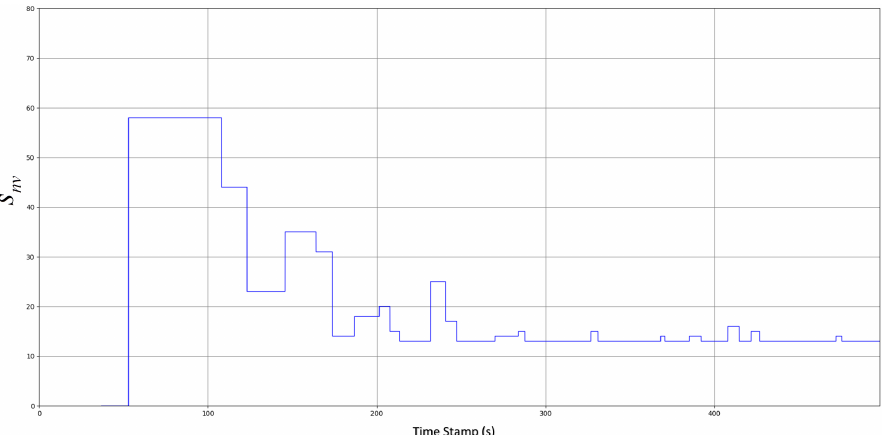
Figure 16. Convergence of termination condition in density-based evaluation is verified, and the density-based evaluation can be satisfied after a certain time of exploration.